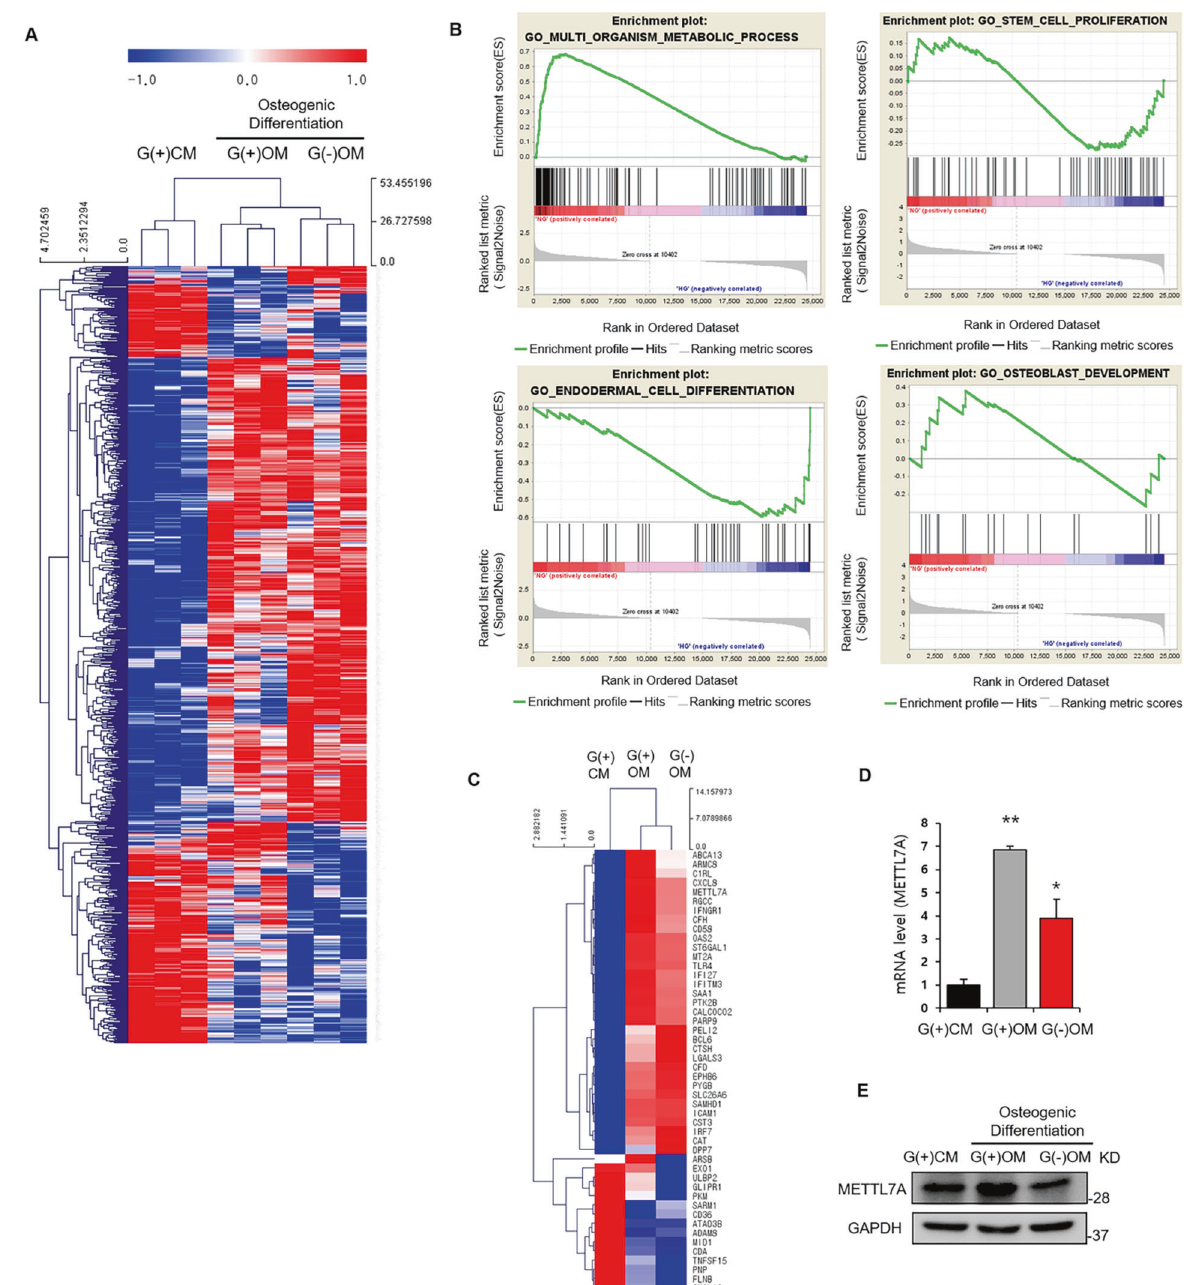
Fig. 2 Identi fi cation of the novel gene associated with enhanced survival and osteogenic differentiation in hBMSCs. A RNA-seq data analysis of hBMSCs. Analysis of hierarchical clusters of genes signi fi cantly related to each sample via RNA-seq data analysis. A heatmap was generated to visualize transcriptomic differences among undifferentiated hBMSCs cultured in control medium with 5.5 mM glucose [G( + )CM], osteo-induced hBMSCs cultured in osteogenic medium containing 5.5 mM glucose [G( + )OM] or no glucose [G( − )OM] (fold-change > 2, P < 0.05). Red indicates upregulation, while blue indicates downregulation. B Pathway analysis in Functional Annotation for signi fi cant probe list was performed using DAVID for G( + )OM and G( − )OM. An analysis of difference in signaling pathways related to metabolic process, stem cell proliferation, cell differentiation, and osteoblast development. C A selected heatmap was generated to visualize relative transcriptomic differences among transcripts from G( + )CM, G( + )OM, and G( − )OM (fold-change > 2, P < 0.05). D Relative gene expression of METTL7A was determined by RT-qPCR, and E Western blot. Data were presented as mean ± standard deviation (SD, N = 3). NS: no signi fi cant difference, * p < 0.05, ** p < 0.01. G( + )CM: undifferentiated hBMSCs cultured in control medium with 5.5 mM glucose; G( + )OM: osteo-induced hBMSCs cultured in osteogenic medium containing 5.5 mM glucose; G( − )OM: osteo-induced hBMSCs cultured in osteogenic medium without the METTL7A group showed substantially better quality of bone signi fi cantly better when implanted with METTL7A-transfected regeneration, and complete healing of the segmental radial defect, hBMSCs (METTL7A; MC-M7 group) compared with control vector- while other groups had insuf fi cient healing or gross nonunion of transfected hBMSCs (MiniCircle; MC group), or without cell implanta- critical-size defects, demonstrated radiographically (Fig. 5B) and via tion (control group) (Fig. 5B). In segmental long-bone defect model,